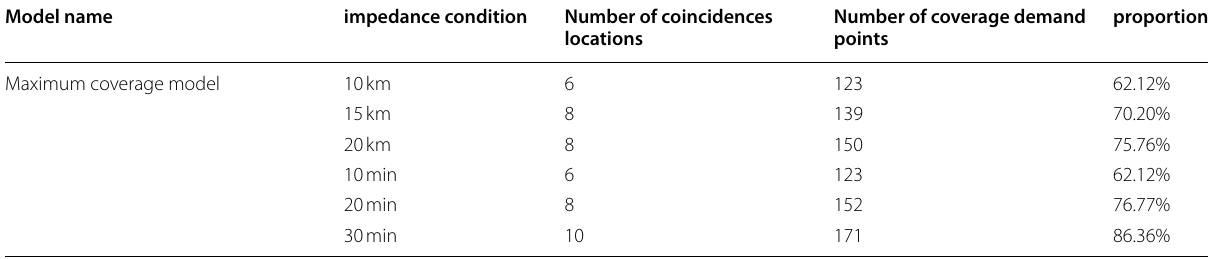
Table 4 Optimization results of maximum coverage model under different impedance